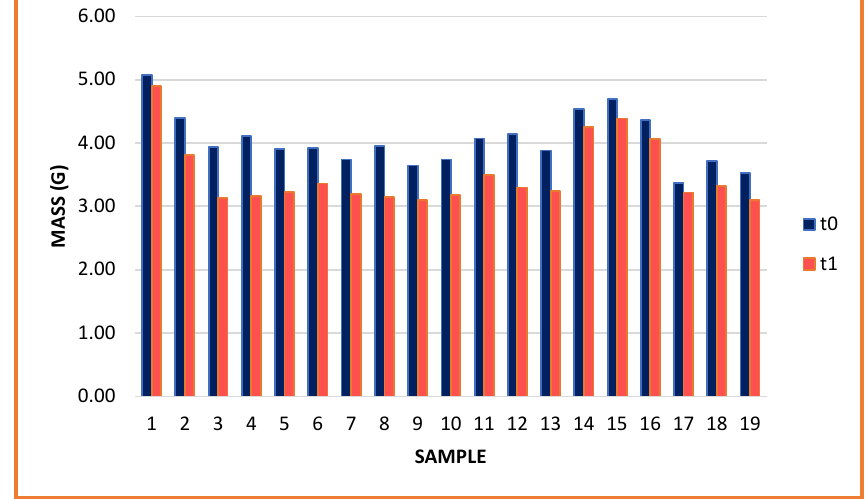
Figure 1. Mass of biopolymeric films.